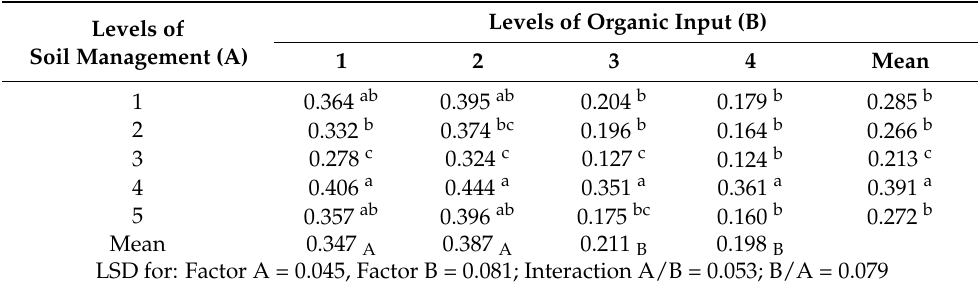
Table 4. Soil respiration intensity ( µ L CO 2 m − 2 h − 1 ), depending on the method of tillage (factor A) and stubble management (factor B) in winter wheat monoculture. Levels of Organic Input (B) Levels of Soil Management (A)